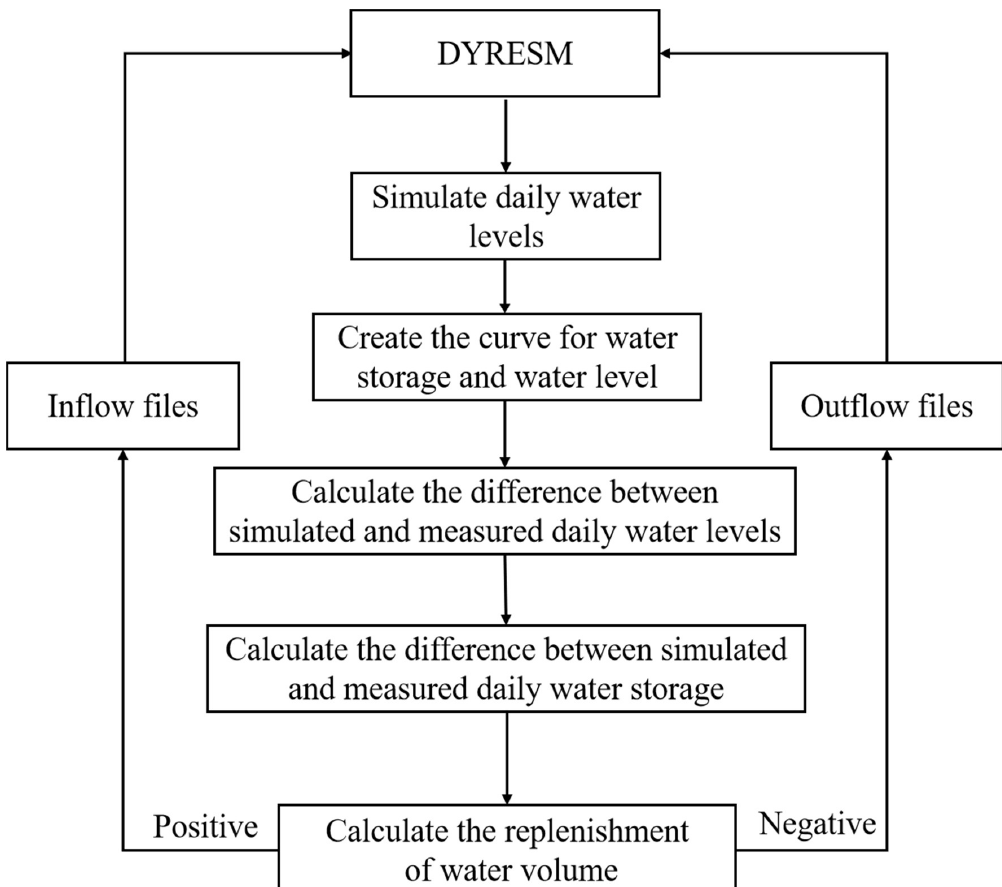
Figure 3. Flowchart of water compensation method for DYRESM.